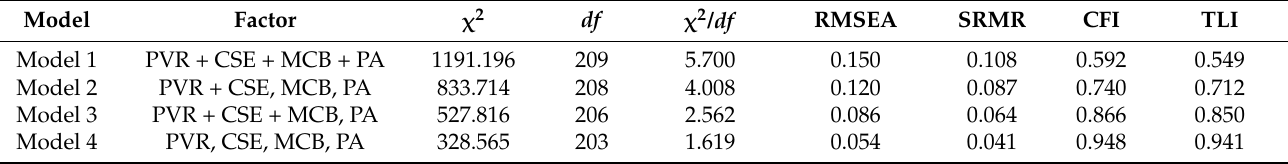
Table 2. Results of validation factor analysis.